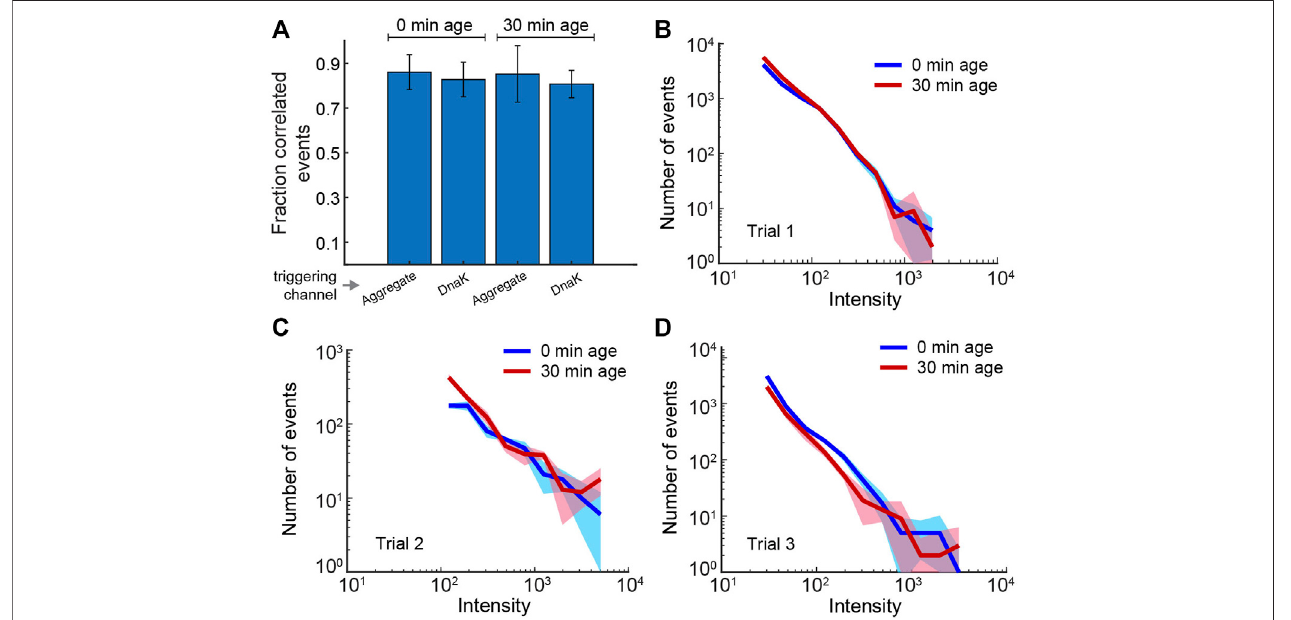
FIGURE 7 | Binding of DnaK to S-type aggregates is not impacted by aggregate particle aging. Binding of fl uorescent DnaK (DnaK517-DBCO488) to both aged and non-aged S-type aggregates (RuBisCO58-Alexa647) was examined using two-color burst co-incidence analysis. Aggregates were grown for 2 min, then diluted ×20 to stop further growth (10 nM fi nal RuBisCO monomer). Samples were either immediately supplemented with the KJE system (10 nM DnaK517-DBCO488, 50 nM DnaJ, 50 nM GrpE and 2 mM ATP) or incubated at 23 ° C for 30 min prior to addition of the KJE system. Following an additional incubation at 23 ° C for 10 min, samplesweretreatedwith0.05 U/µlhexokinaseand20 mMglucosetodepleteATPandstopchaperoneturnover. (A) Eachbarshowsthefractionofdetectedeventsin theupper50%ofintensitythatarecoincidenttowithin0.5 ms.Becausetheef fi ciencyofcoincidentbindingwasnotknown apriori, theaveragecoincidenceineachcolor channel ( aggregate, DnaK ) after 0 and 30 min of aging was separately considered. The reported uncertainties re fl ect the spread in coincidence for three experimental repeats andsuggestno changeinbindingef fi ciencybyDnaKuponaggregateaging. (B – D) TheDnaKcolorchannelburst intensityhistograms (0.5 mstime bins;events greater than the minimum threshold — see Methods ) for each of the three repeats used in panel (A) . The color bands represent statistical uncertainty based on the measuredhistogrambinvariance.Theoverallstabilityofthemeasureddistributions indicatethatDnaKbindingisnotsigni fi cantlyimpactedbyaggregateaging.Thehigh concentration of unbound DnaK in these experiment leads to background fl uorescence that precludes extending to MC-BAS coincidence